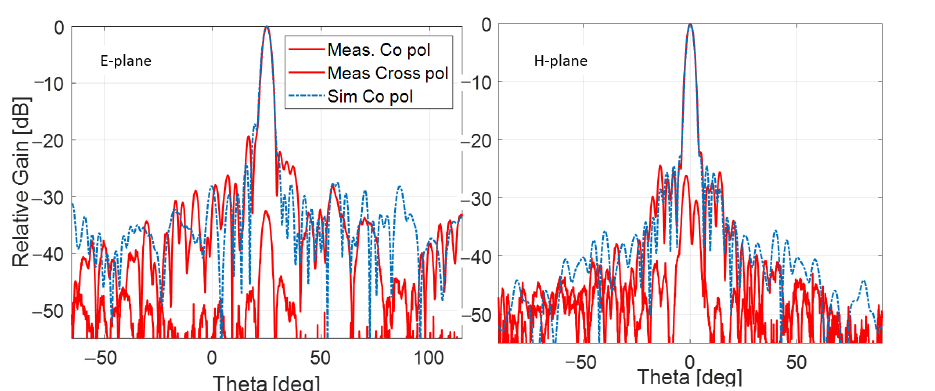
Figure 9. Radiation patterns in the E ( left ) and H ( right ) planes at 30 GHz.